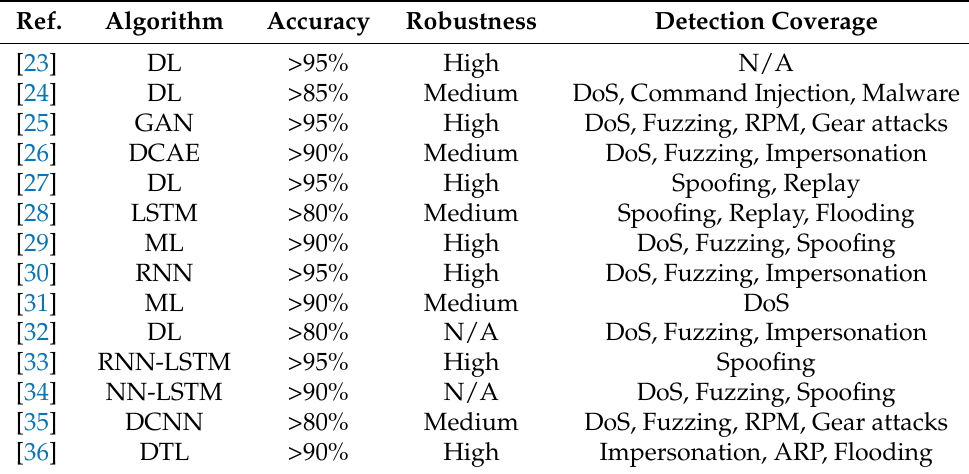
Table 1. Overview of recent research on IDSs for in-vehicle